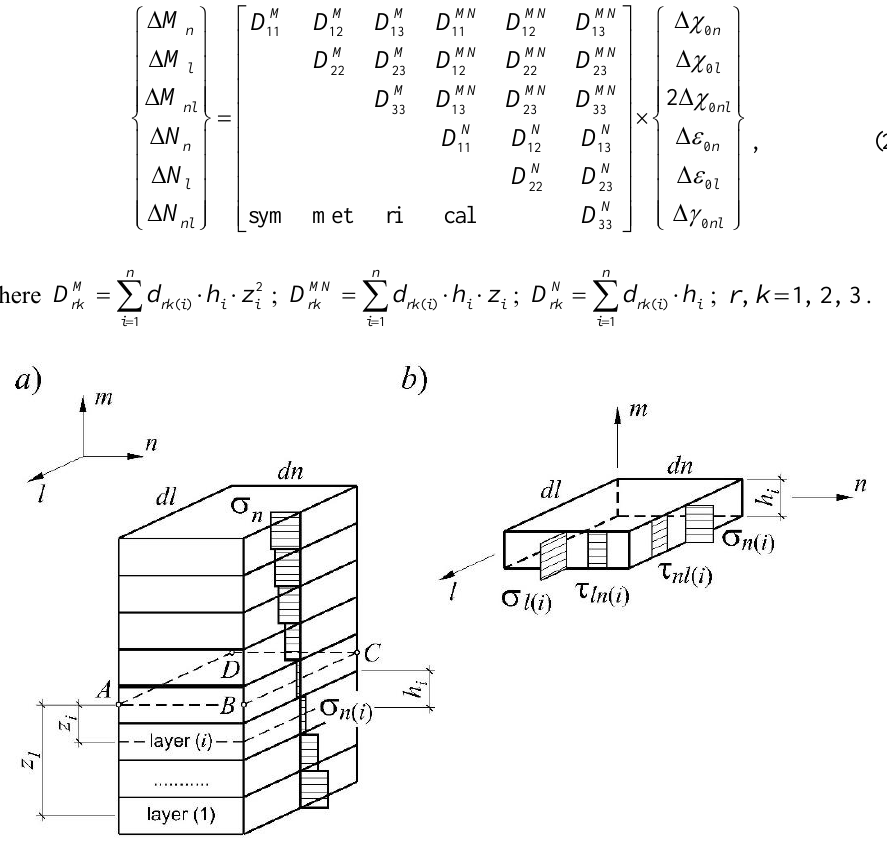
Fig. 1. The scheme of the stress state of the slab element in the main strain axes: a – element of the slab, conventionally divided into segments of small thickness; b – stress state of a separate layer. d represent elements of elasticity matrix of the separate layer. The The elements ( ) rk i